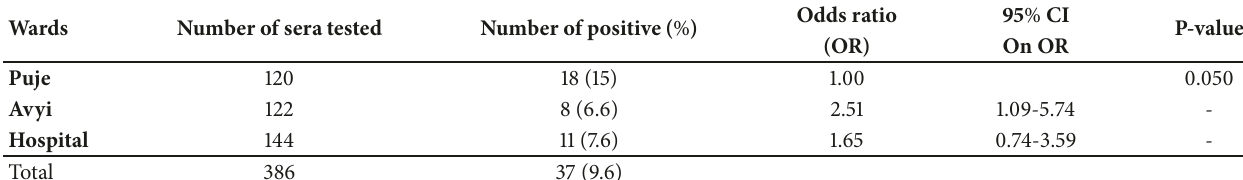
Table 1: Seroprevalence of antibodies to brucellosis in goats sampled in Wukari based on wards. Wards